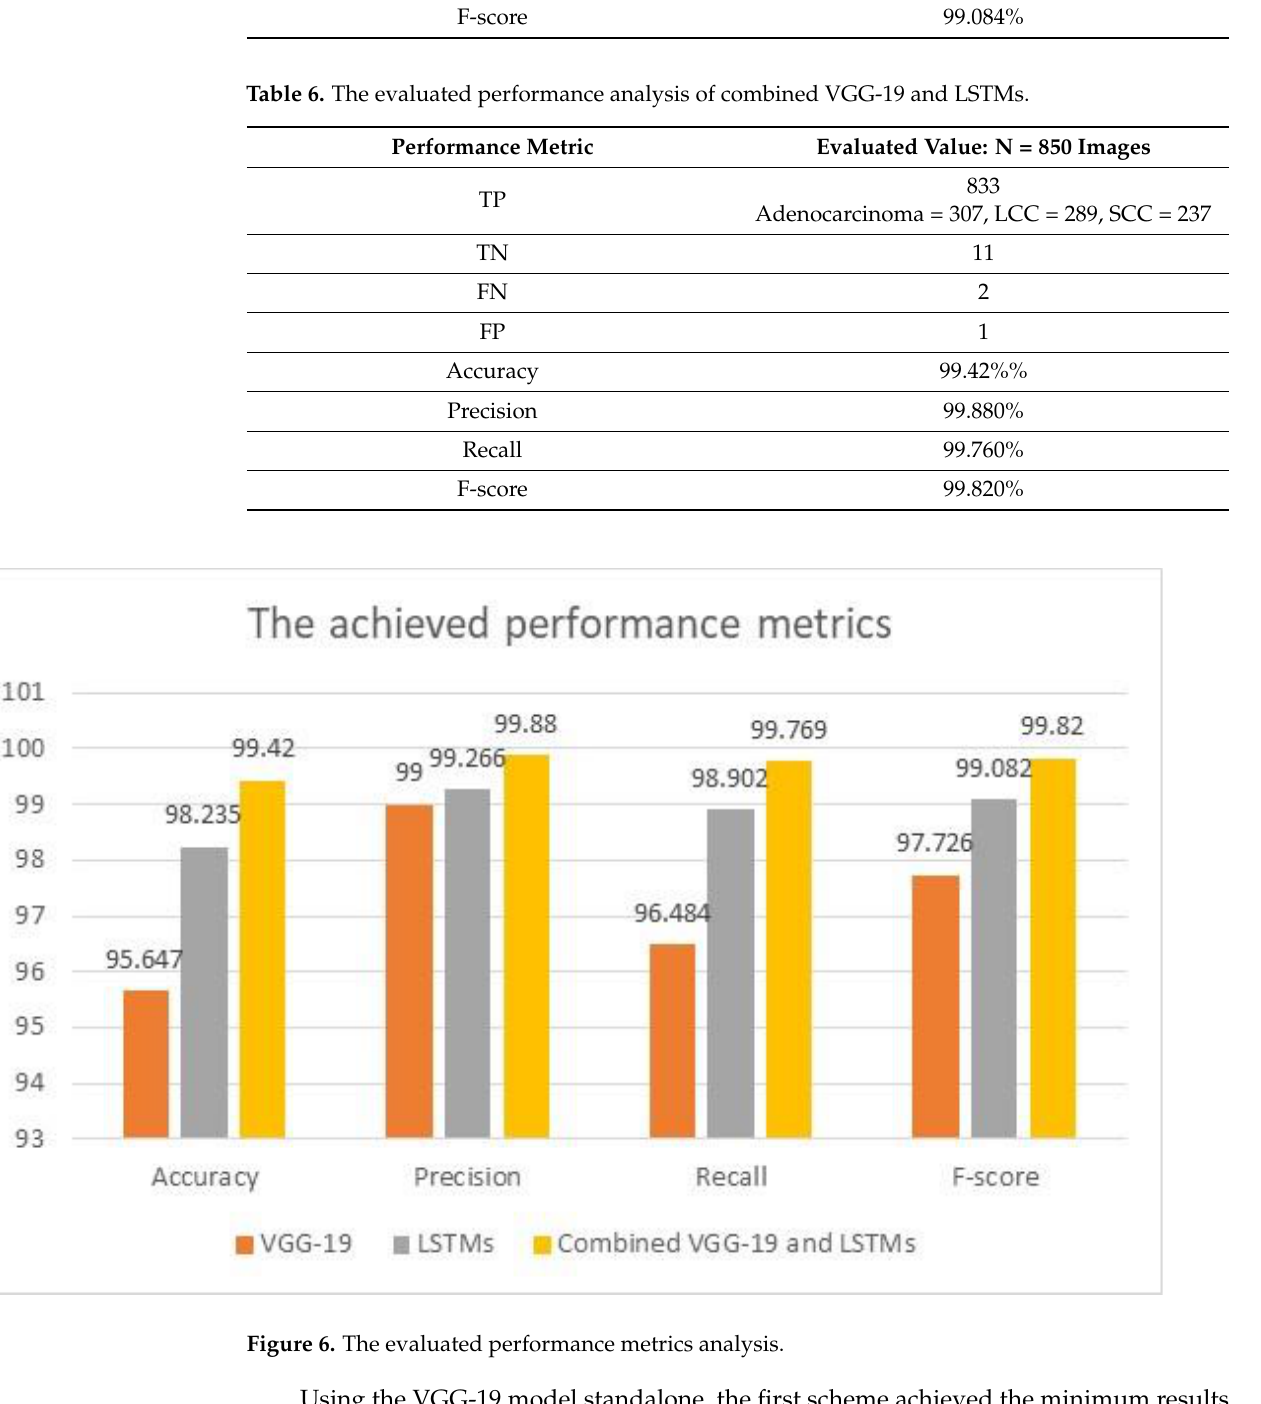
Table 6. The evaluated performance analysis of combined VGG-19 and LSTMs.